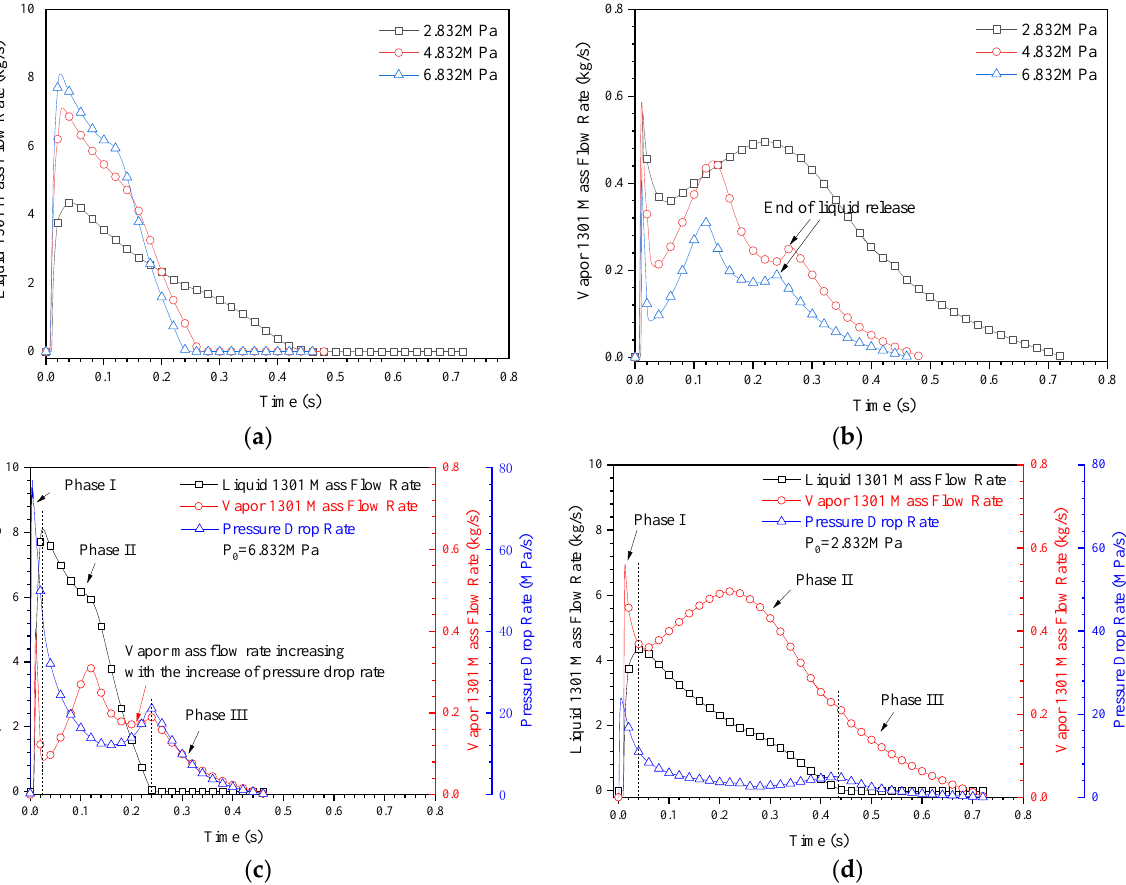
Figure 9. Mass flow rates of extinguishing agent under different filling pressures: ( a ) liquid mass flow rates; ( b ) vapor mass flow rates; ( c ) mass flow rate and pressure drop rate under 6.832 𝑀𝑃𝑎 ; ( d ) mass flow rate and pressure drop rate under 2.832 𝑀𝑃𝑎 .